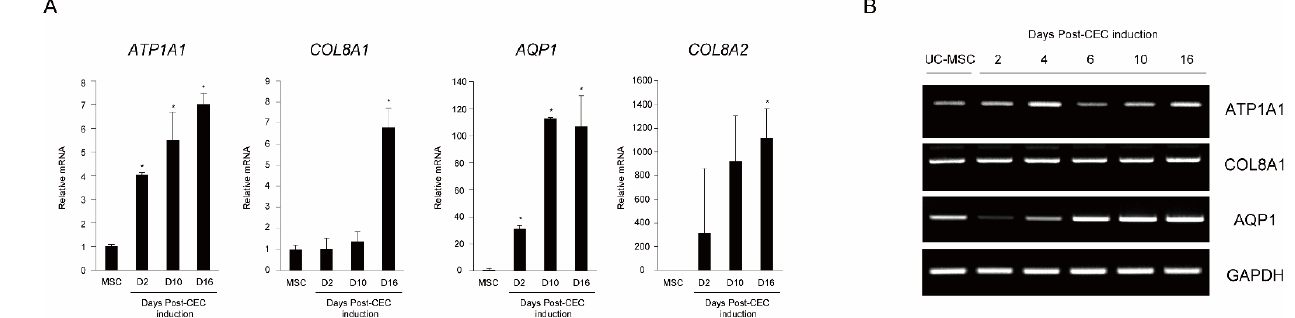
Figure 2. Quantitative RT-PCR and RT-PCR. ( A ) Quantitative RT-PCR (qRT-PCR) analysis of the expression of representative MSC, and CEC genes. ( B ) Gel image of RT-PCR showing MSC and CEC-related gene expression. (* p < 0.05)